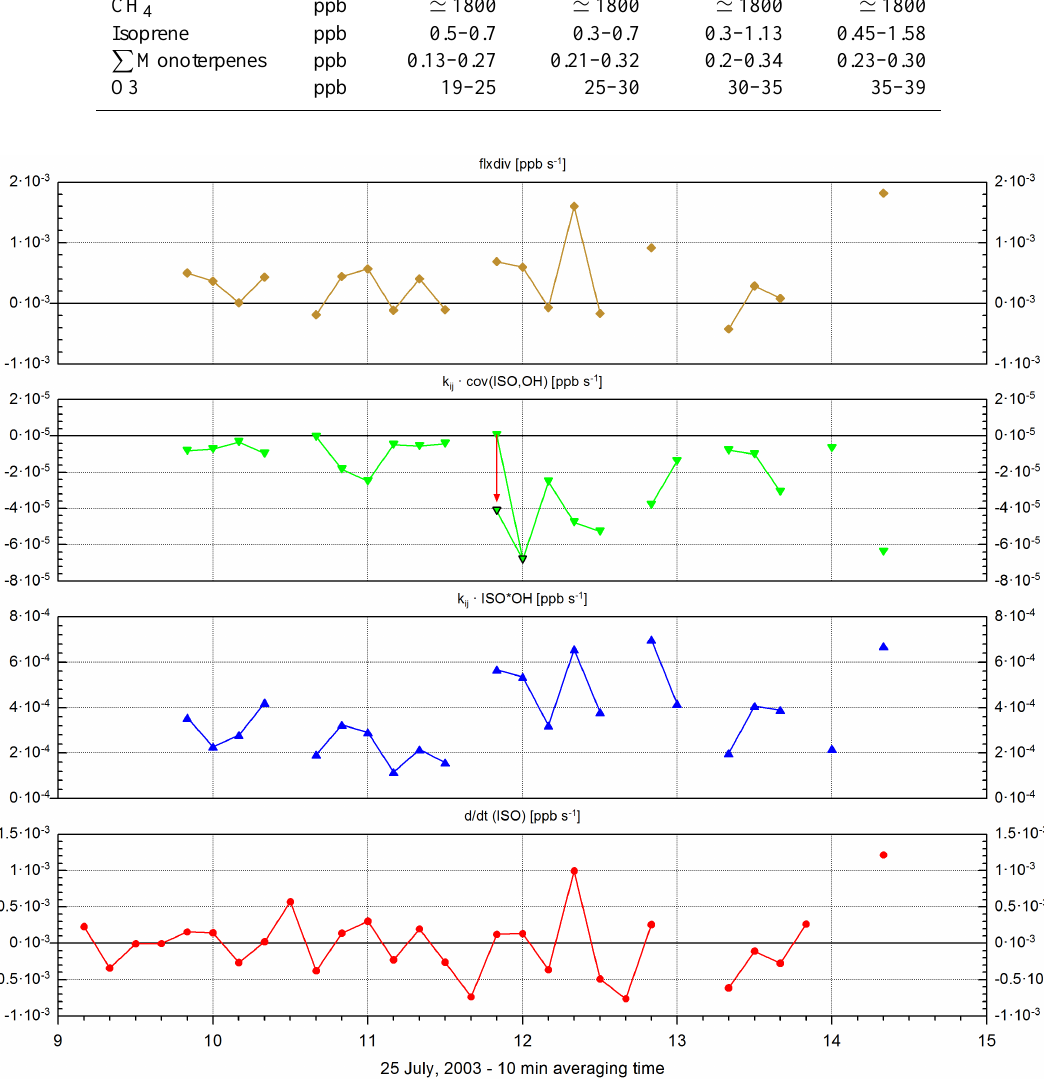
Figure 2. The four terms of the balance equation for the mixing ration of isoprene (Eq. 5) calculated according the finite difference method as described in the text. The correction of the covariance is explained in Sect.